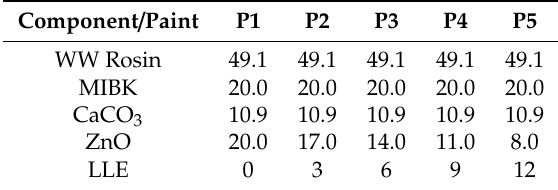
Table 2. Coating formulation by wt.